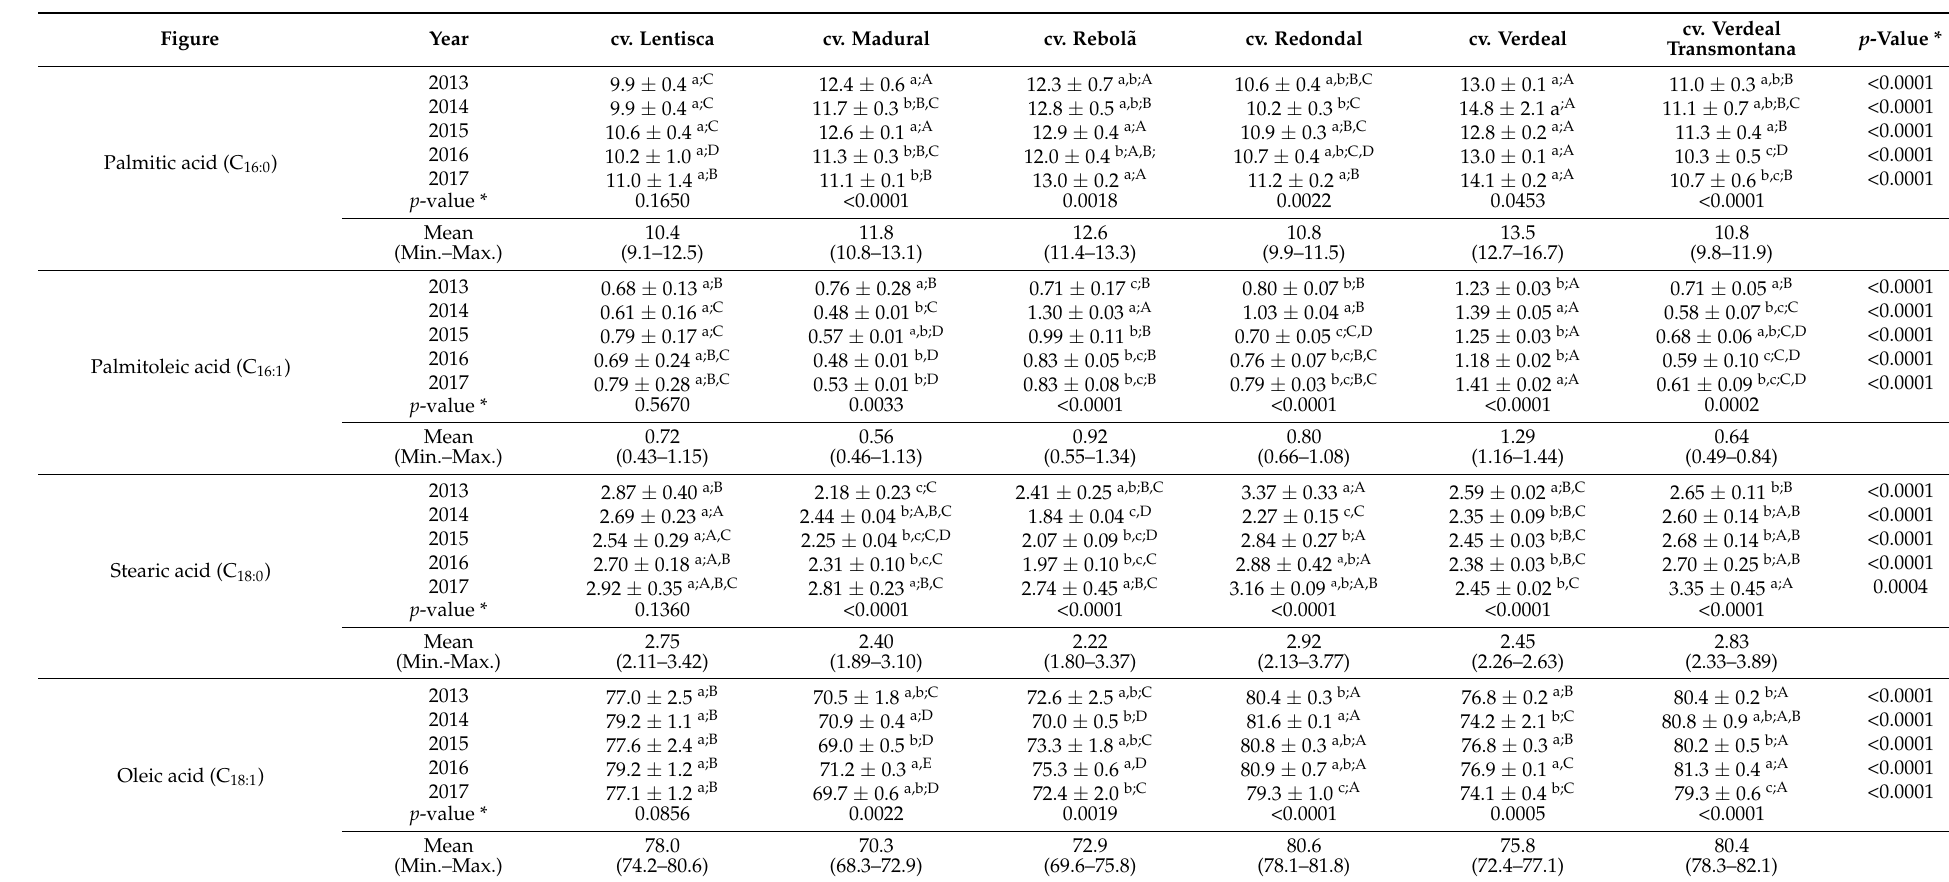
Table 1. Fatty acid composition (%) (mean ± standard deviation) of olive oils extracted from olives collected in centenarian trees of different cultivars (cvs. Lentisca, Madural, Rebol ã , Redondal, Verdeal, and Verdeal Transmontana) during five consecutive crop years (2013 to 2017). Figure Year cv.